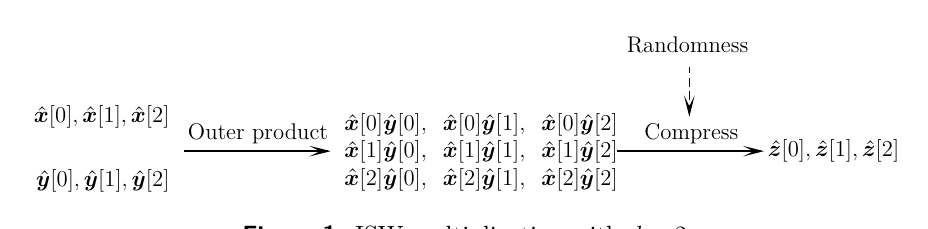
Figure 1: ISW multiplication with d =